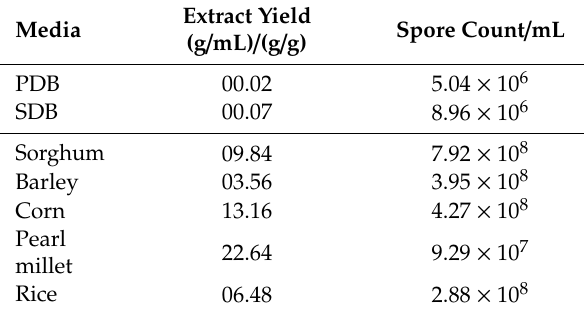
Table 5. Spore count and extract yield from the di ff erent culture media (liquid and solid) of EFI 671. PDB: Potato Dextrose Broth; SDB: Sabouraud